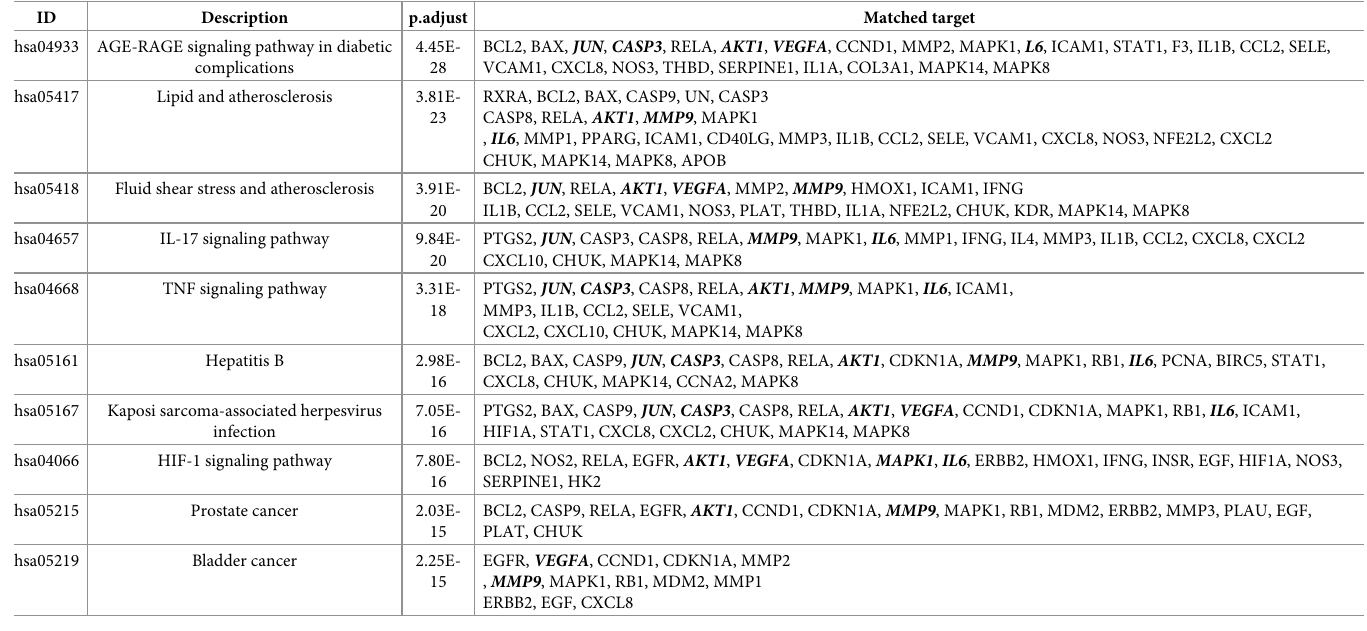
Table 1. Table of the top 10 KEGG signaling